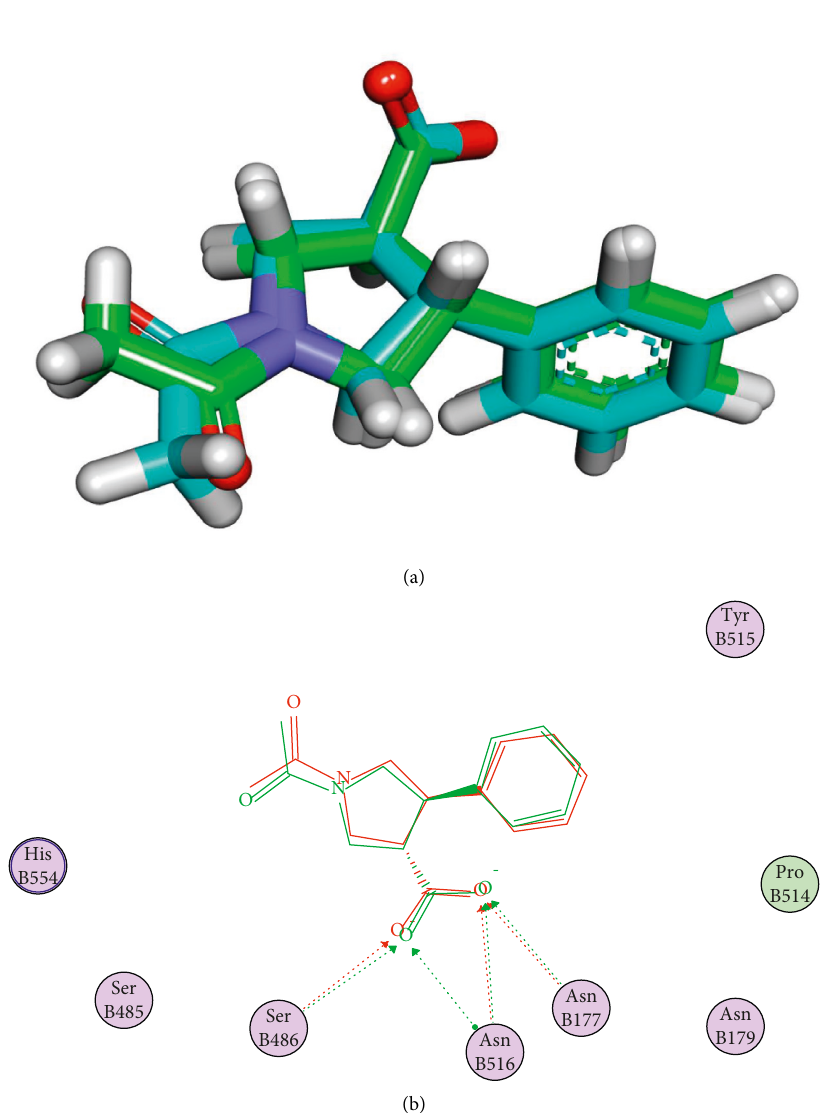
Figure 4: (a) 3D and (b) 2D superimposition of the re-docked conformer of VXG over the co-crystallized one with an RMSD value of 0.74A. Table 3: ∆ G (in kcal/mole) of the most similar 40 compounds to VXG .